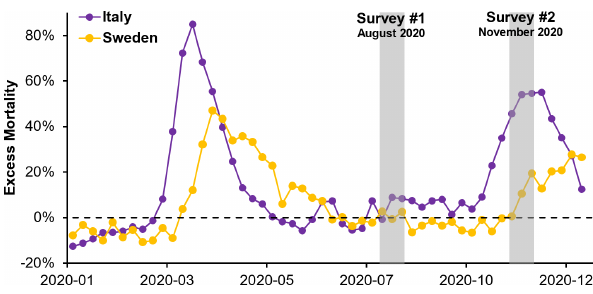
Figure 1. Nationwide surveys under the COVID-19 pandemic. Ex- cess mortality data derived from the human mortality database (Kar- linsky and Kobak,